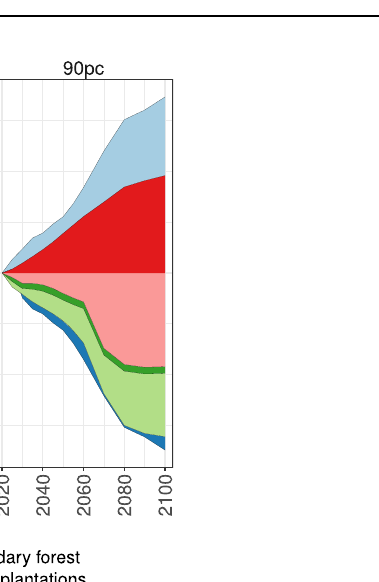
forthe indicatedland-use type compared to 2020. As the geographicalland areais constant, the sum of positive changes (expansion) and negative changes (reduc- tion) is always zero i.e., an expansion of a particular land-use type always comes at the cost of a reduction of another land-use type.